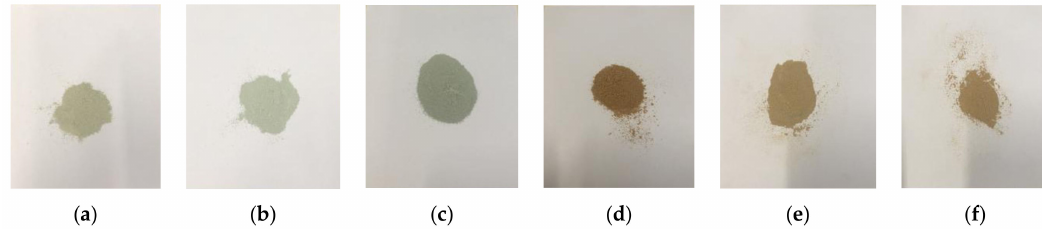
Figure 2. Materials: ( a ) thermally modified zeolite (TMZ), ( b ) sodium chloride modified zeolite (SCMZ); ( c )naturalzeolite(NZ),( d )diatomite(D),( e )compositeadsorbent(TMZ / D = 3:2), ( f )compositeadsorbent (TMZ / D =